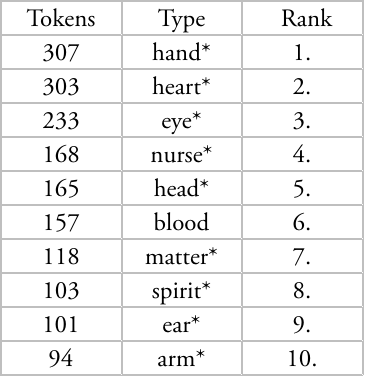
Table 3: Frequency ranking in 1 , 2H4 , Wiv. , Rom. , Tro., Tim., Oth., JC, Per. (from List C). Apart from these remarks, a basic issue arises from the concordance data, relating to the lexical richness of the selected plays: the number of word types